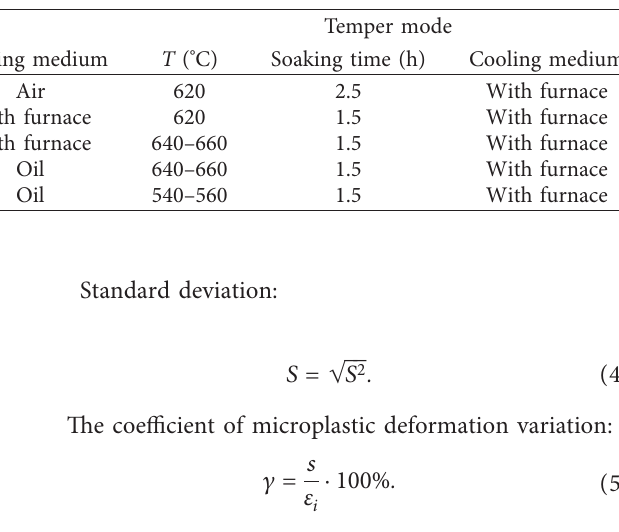
Table 4: Modes of deposited samples heat treatment for microplasticity testing.